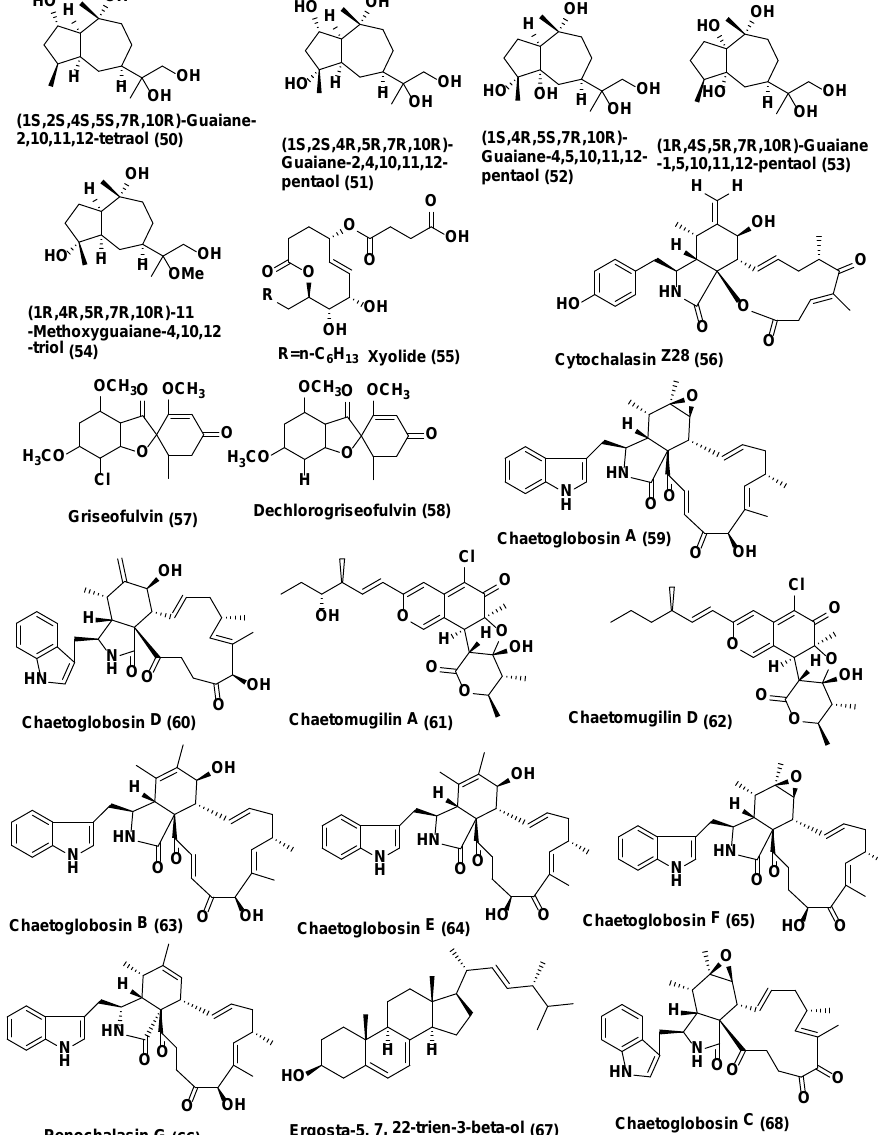
Figure 3. Structures of metabolites isolated from Ascomycetes ( 50 – 68